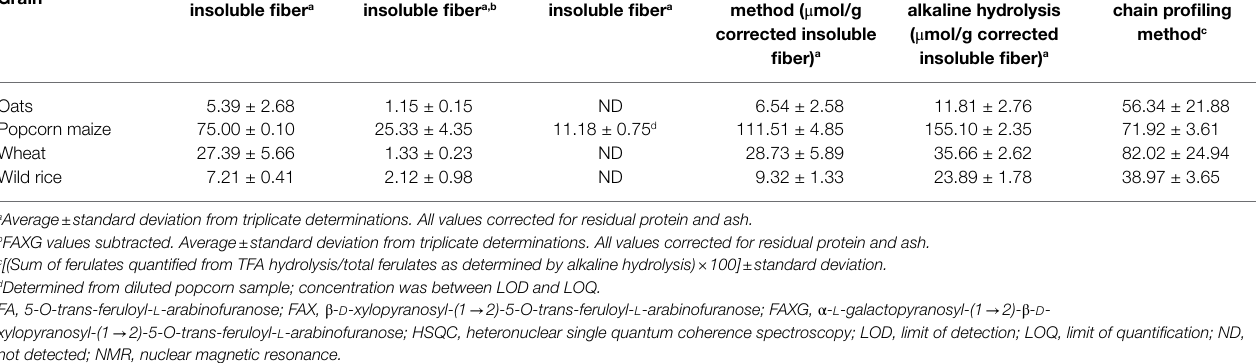
TABLE 3 | Application of the semi-quantitative HSQC-NMR feruloylated side-chain profiling method to insoluble fibers from whole grains.